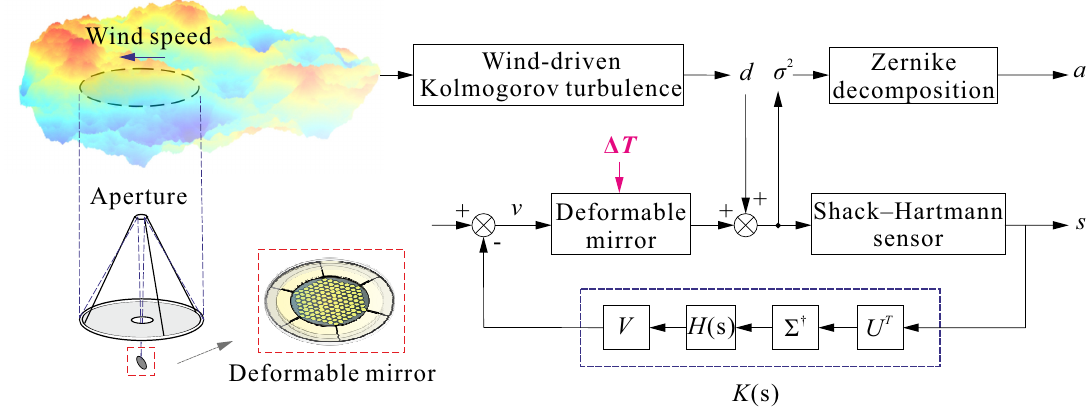
Figure 3. Block diagram of the control system. The input–output relationship is s = J v .